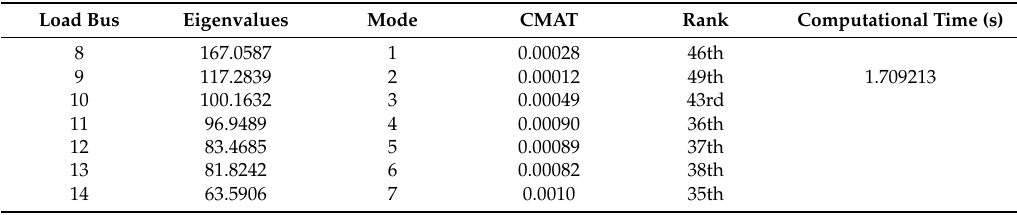
Table 11. Results of the CMAT for the IEEE 57-bus power